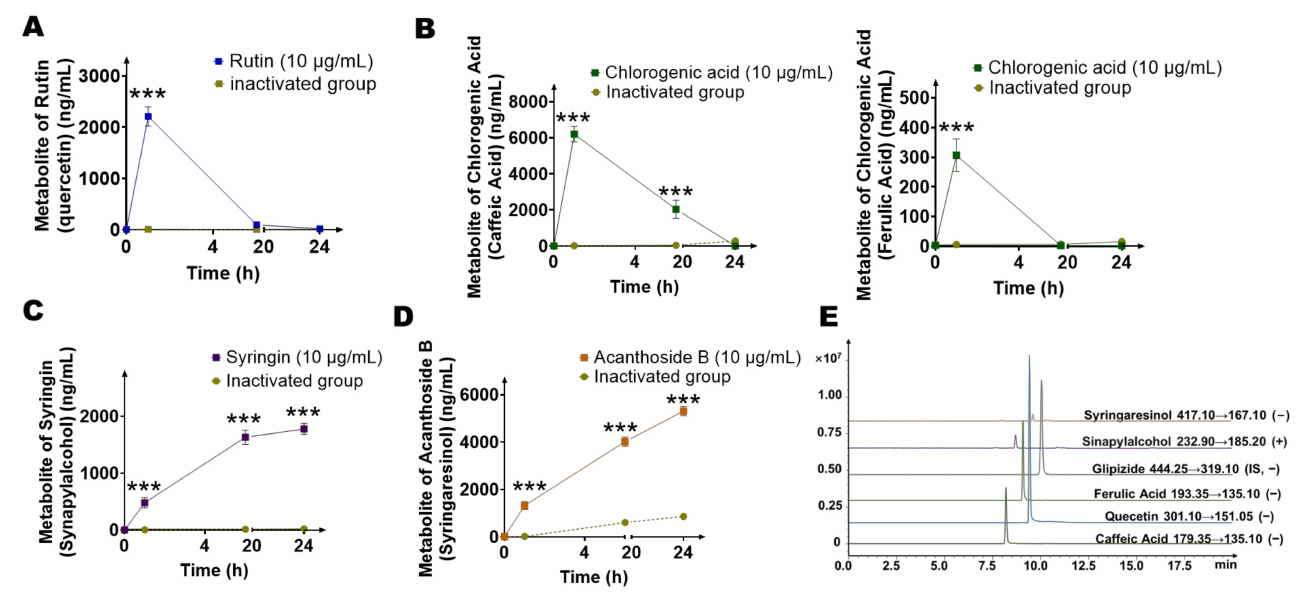
Figure 5. Quantitative analysis of intestinal bacterial metabolites of four main components (chloro- genic acid, syringin, acanthoside B, rutin) of Saussurea involucrata . ( A ) Metabolic curve of quercetin (metabolite of rutin) ( n = 3). ( B ) Metabolic curve of caffeic acid and ferulic acid (metabolites of chlorogenic acid) ( n = 3). ( C ) Metabolic curve of synapylalcohol (metabolite of syringin) ( n = 3). ( D ) Metabolic curve of syringaresinol (metabolite of acanthoside B) ( n = 3). ( E ) Extracted ion chro- matogram (EIC) spectra of syringaresinol, sinapylalcohol, ferulic acid, quercetin, caffeic acid, and the internal standard (glipizide). Data are presented as mean ± SD, and two-tailed Student’s t test was used for analysis (*** p <